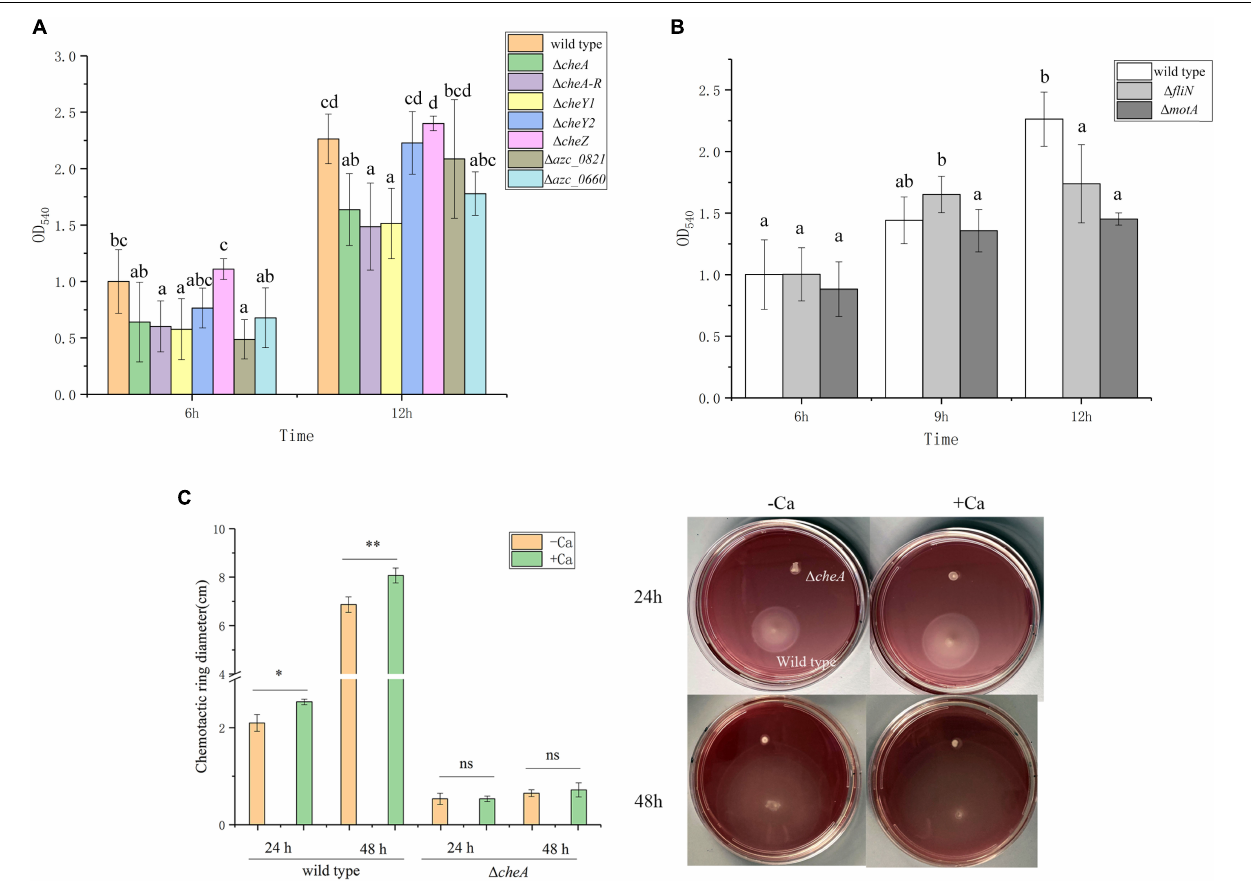
FIGURE 4 | Biofilm formation of wild type and different chemotaxis and motility defective mutants. (A) Biofilm formation of chemotaxis defective mutants (cid:49) cheA , (cid:49) cheA-R , (cid:49) cheZ , (cid:49) cheY1 , (cid:49) cheY2, (cid:49) azc_0821, and (cid:49) azc_0660 with TY medium after 6 and 12 h. (B) Two motility defective mutants (cid:49) fliN and (cid:49) motA form biofilm with TY medium after 6, 9, and 12 h. The same letter above the error bars indicates not statistically different with results under same culturing time by a Duncan’s test. (C) Swimming behavior of A. caulinodans wild type and (cid:49) cheA on soft-agar plates with or without 6 mM calcium. Asterisks ( ∗ P < 0.05; ∗∗ P < 0.01) show a significant difference between conditions according to a t -test. Values are shown as the means and standard deviations from at least three independent